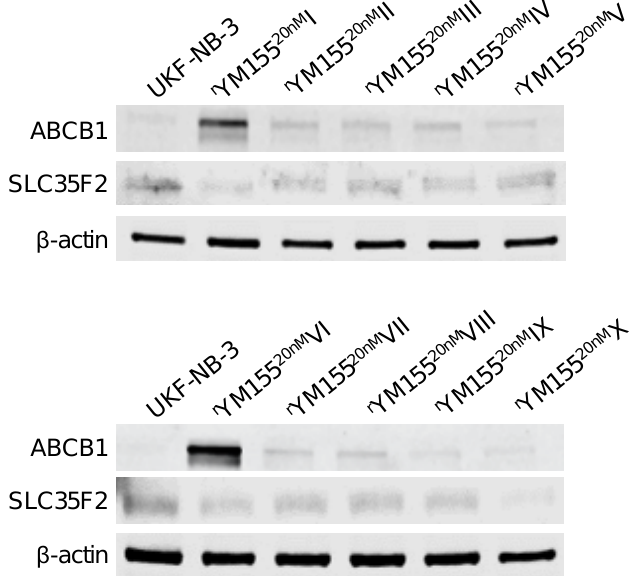
Figure 7. Representative Western blots indicating cellular levels of ABCB1 and SLC35F2 in UKF-NB-3 and YM155-adapted UKF-NB-3 sublines. YM155-adapted sublines are typically characterized by increased ABCB1 levels and decreased SLC35F2 levels. Uncropped blots are shown in Figure S5.